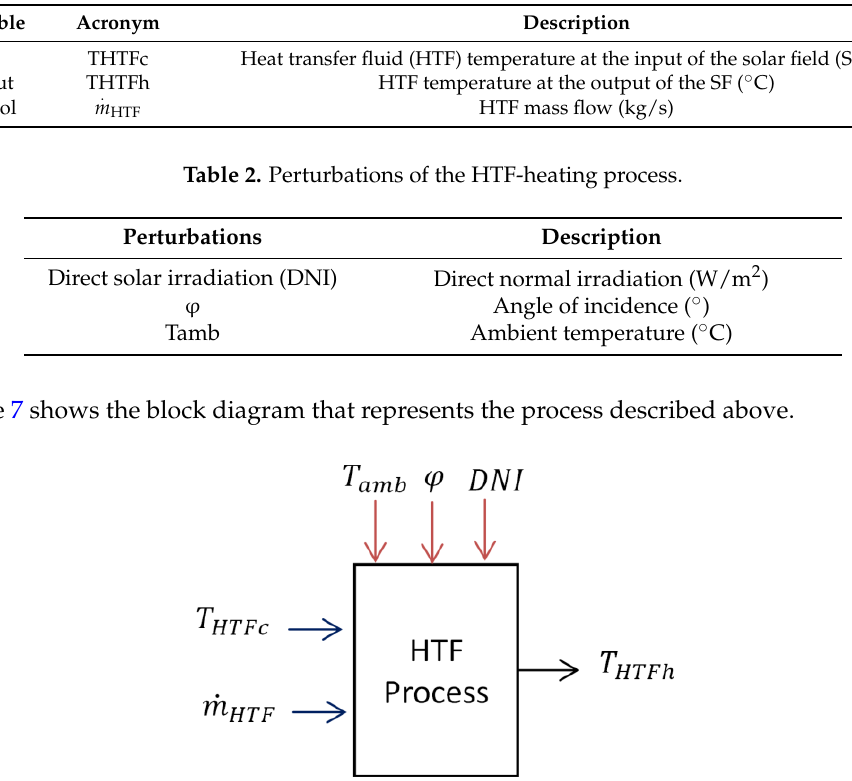
Table 1. Input, output and control variables of the HTF-heating process.